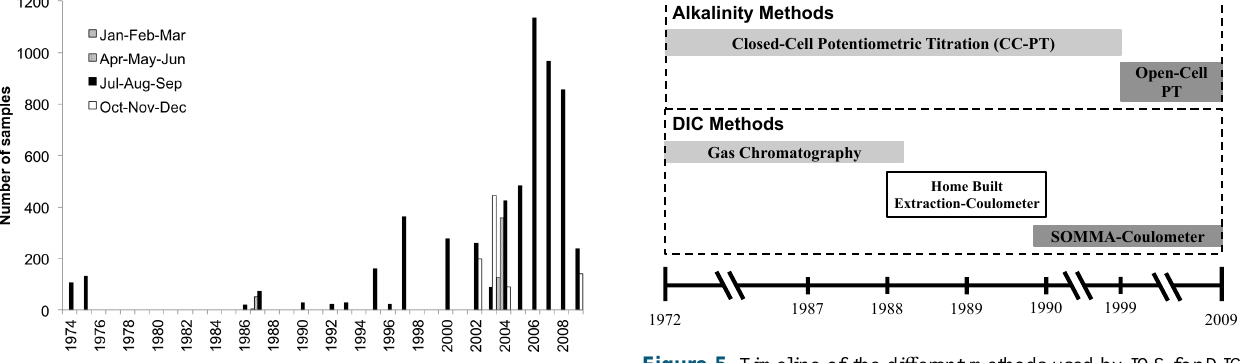
Figure 3. Distribution of carbon system measurements (alkalinity, DIC and / or pH) included in the data set by year, categorized into three-month spans.